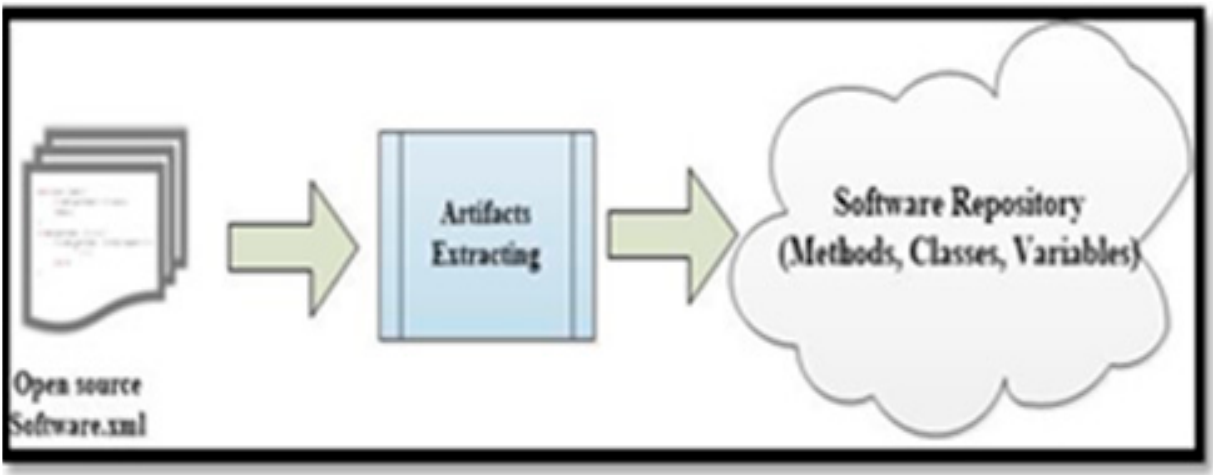
Figure 6. The extraction process of software artifacts.